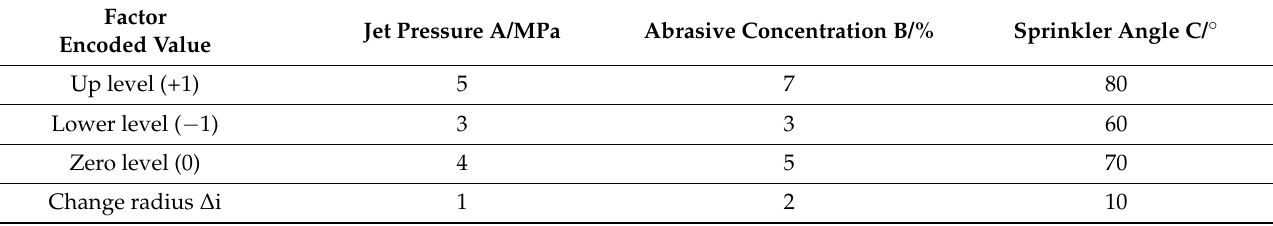
Table 3. Factor level and coded value correspondence table.